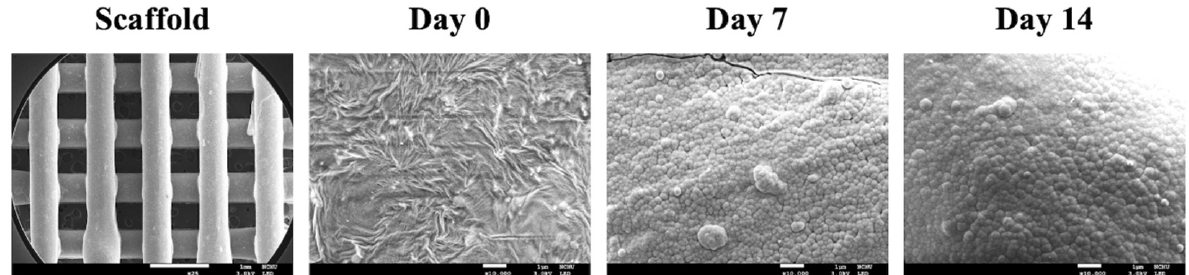
Figure 3. Field emission–scanning electron microscopy (FE-SEM) photographs of the SrCS scaffold before and after soaking in DMEM for different time-points. The scale bars of low-magnification and high-magnification SEM are 1 mm and 1 µm, respectively.